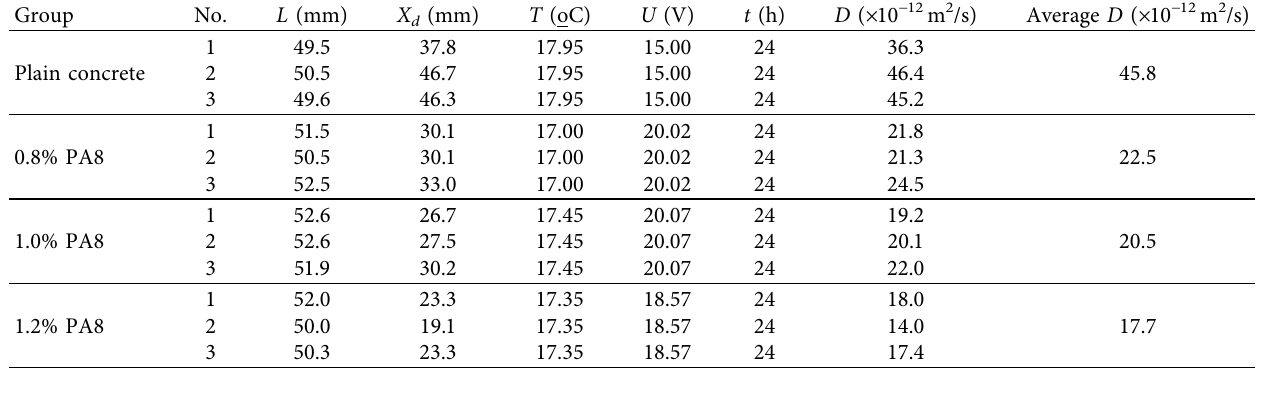
Table 2: Experimental results of chloride diffusion coefficient.